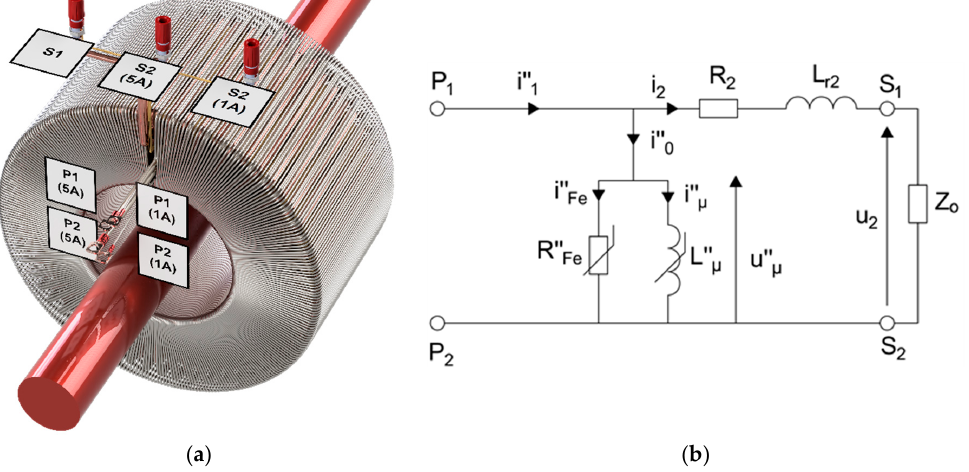
Figure 1. ( a ) 3D view of designed wideband current transformer (CT), ( b ) equivalent circuit of inductive